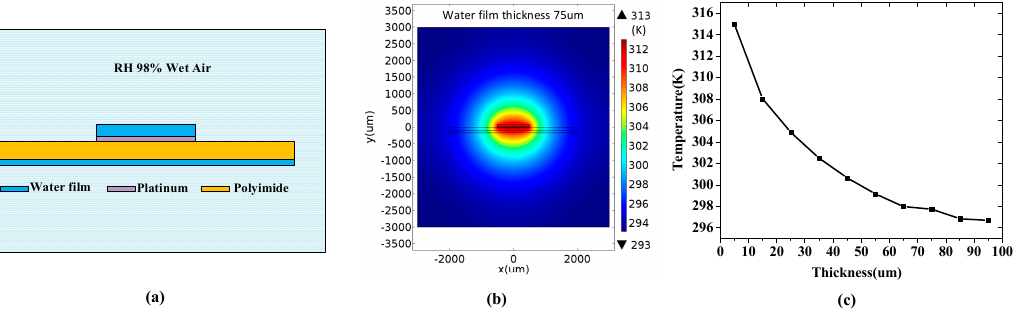
Figure 3. ( a ) Schematic view of hot-film covered by thin water film in 98% RH wet air; ( b ) Simulated temperature distribution around the hot-film; ( c ) Hot-film temperature changing with the thickness of the water film.